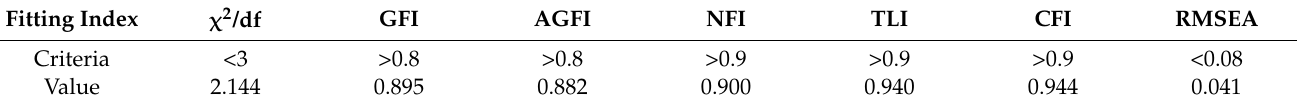
Table 9. Parameters in structural equation model.